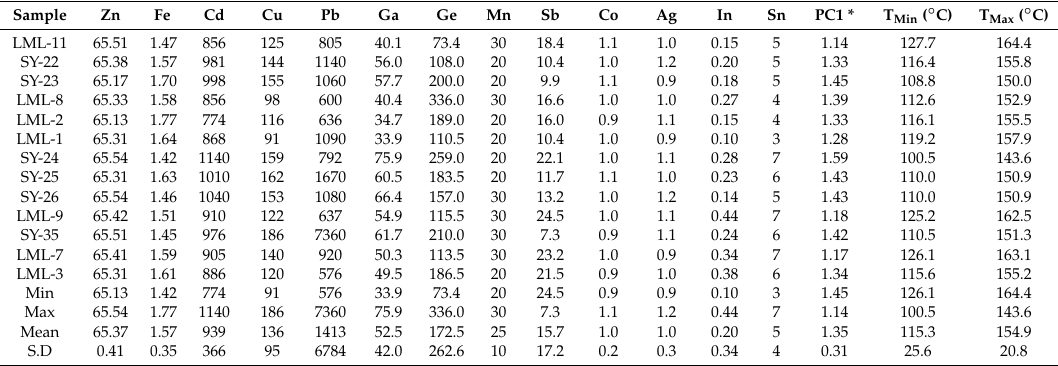
Table 2. Elemental composition of bulk grain sphalerite determined with ICP-MS and the ore-forming temperature of the Nayongzhi deposit calculated by the GGIMFis geothermometer [7]. Sample